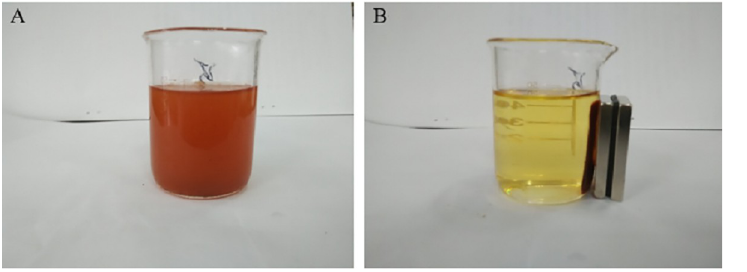
Fig 1. Magnetic separation of MMS (A: before adsorption; B: after